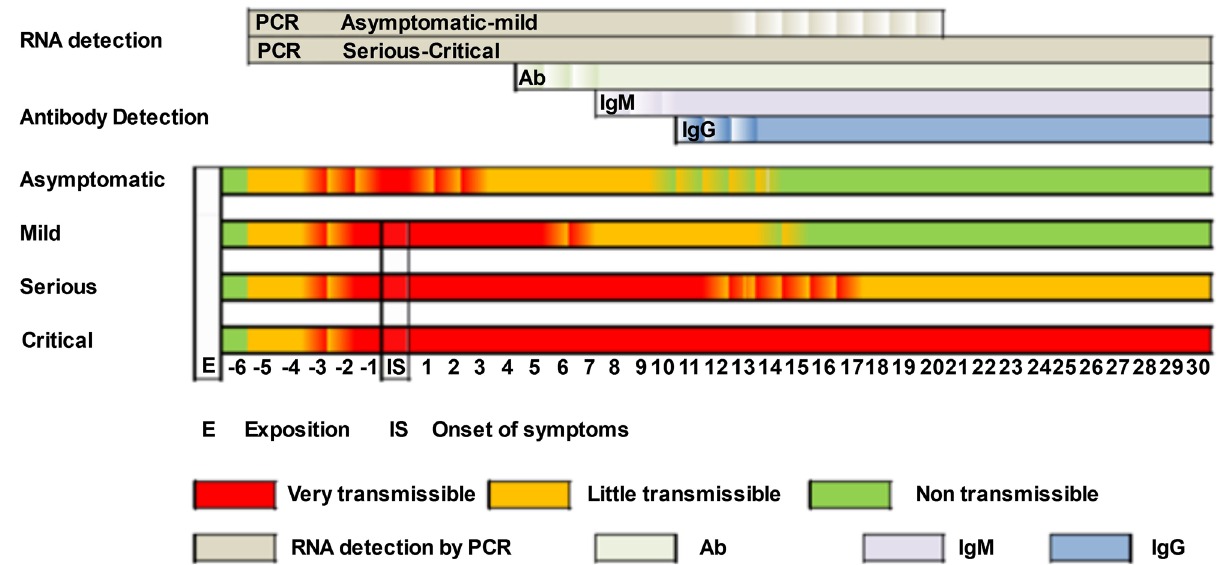
Figure 4. Detection periods of SARS-CoV-2 RNA by PCR and antibodies by serological techniques. On the X axis we can see the number of days that have elapsed, with day 0 being the onset of symptoms. The white stripe of letter “E” indicates the date of exposure to the virus and the beginning of the infection (Instituto de Salud Carlos III).